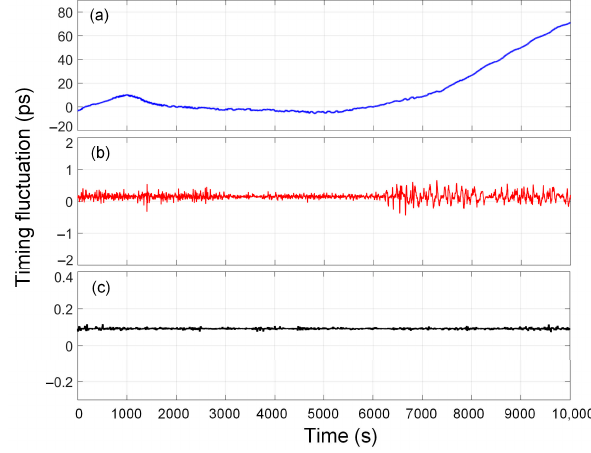
Figure 4. Timing fluctuation results. ( a ) Without phase compensation. ( b ) With phase compensation. ( c ) The measurement floor attributed by the short link. The sample rate is 1 point/second for all curves.